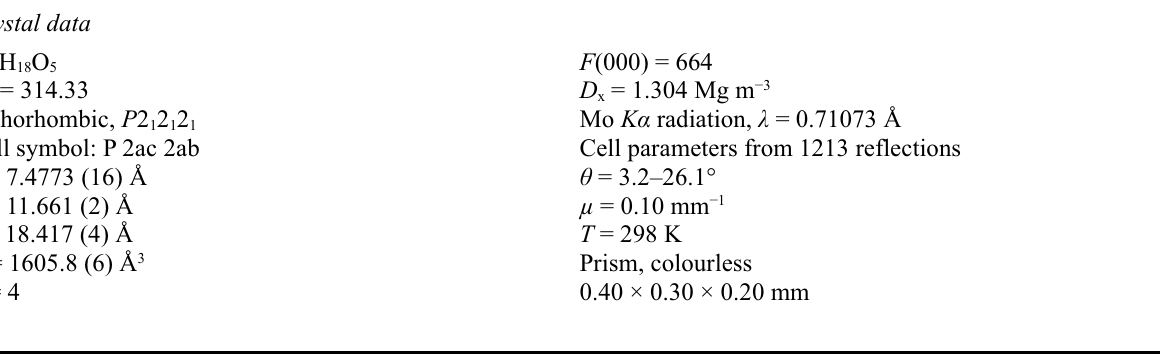
The crystal structure of the title compound, viewed along the c axis. Hydrogen bonds are shown as dashed lines. Ethyl